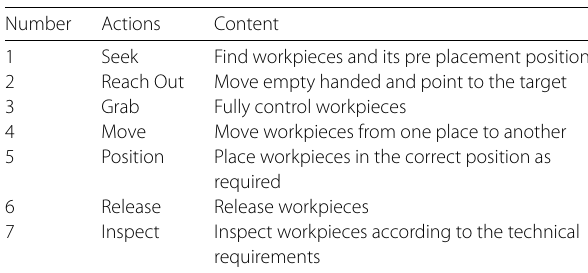
Table 4 Positioning of workpiece